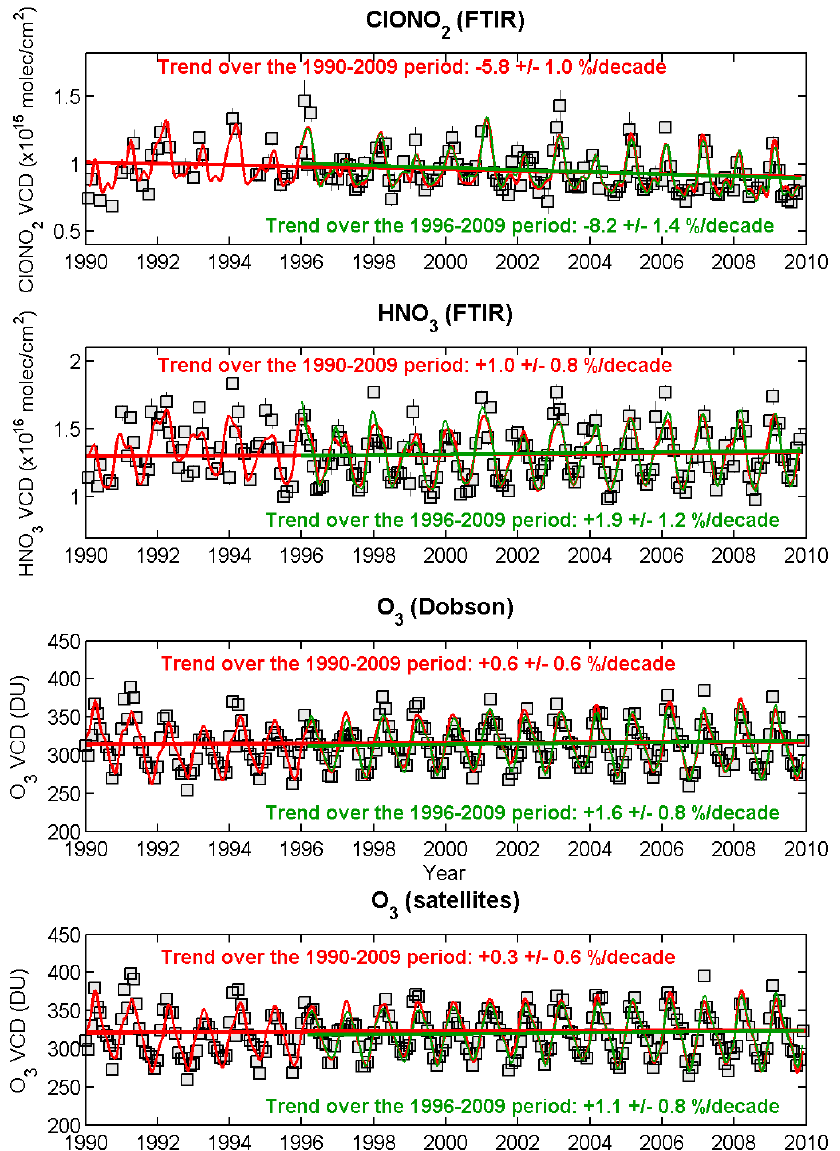
Fig. 8. Results of the trend analysis of the ClONO 2 , HNO 3 , and O 3 total columns measured above Jungfraujoch (above the Arosa station for Dobson measurements). Trend values are relative to year 2000.